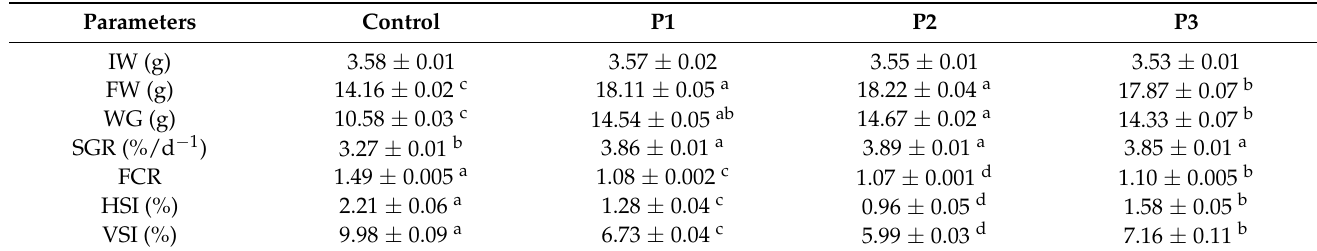
Table 3. Growth performance of rainbow trout fed four experimental diets with different inclusion levels control: 0, P1: 5, P2: 10, and P3: 20 g of apple pomace derived pectin (APDP) for 30 days. Values are presented as the mean ± SE.